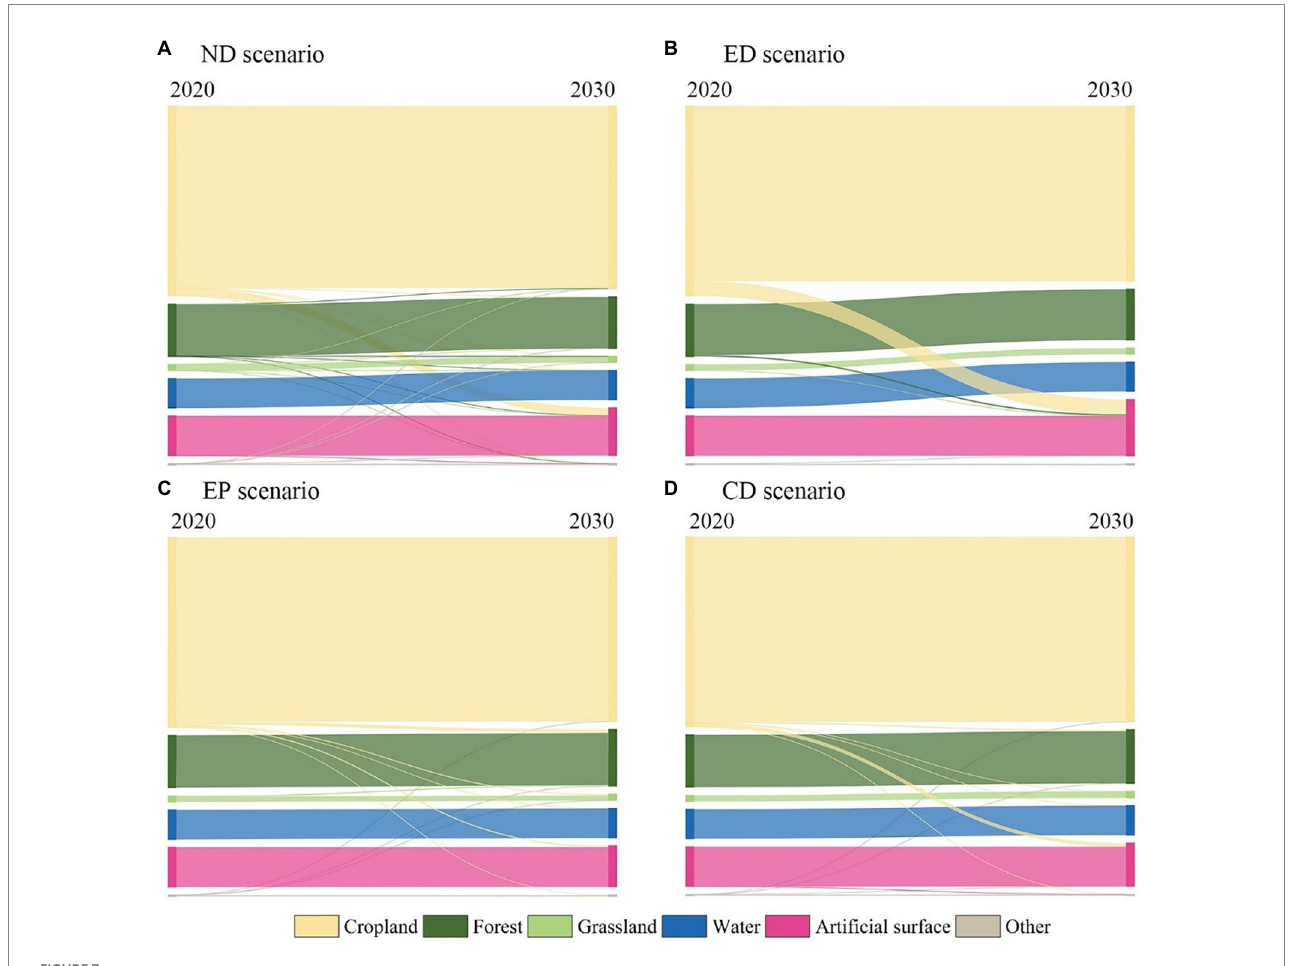
FIGURE 7 Land use type conversions from 2020–2030 under four scenarios: (A) ND; (B) ED; (C) EP; and (D)